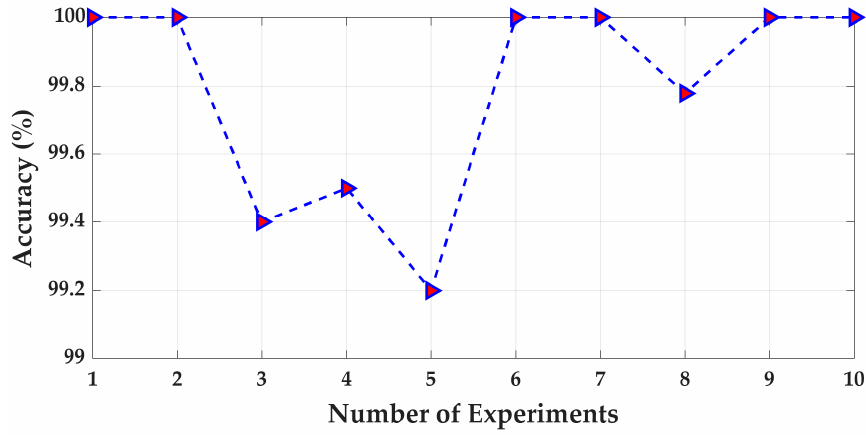
Figure 11. Classification performance of the proposed approach determined for 10 experiments.